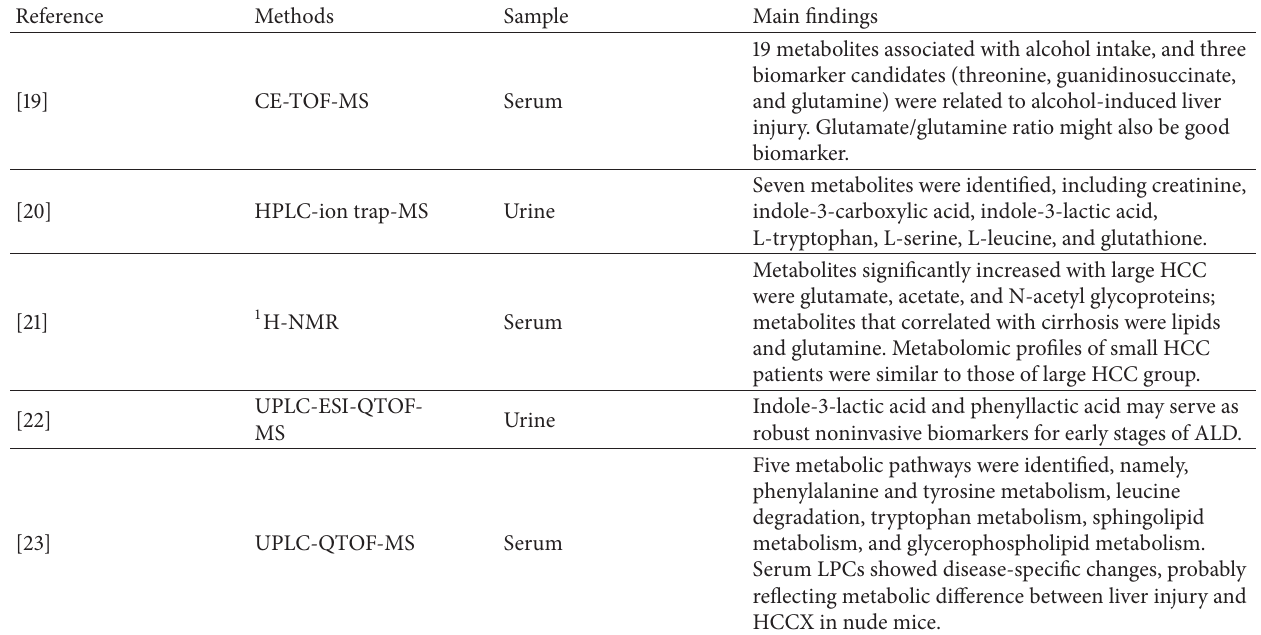
Table 2: The main results of clinical and experimental metabolomic studies on